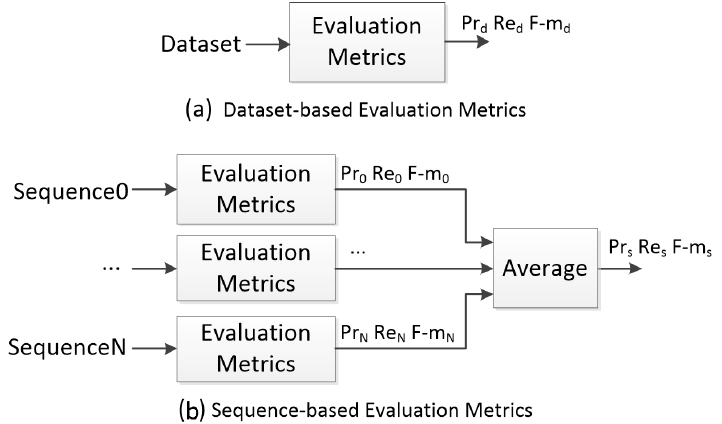
Figure 9. Dataset-based and sequence-based evaluation metrics. Figure 10. Dataset-based and sequence-based evaluation